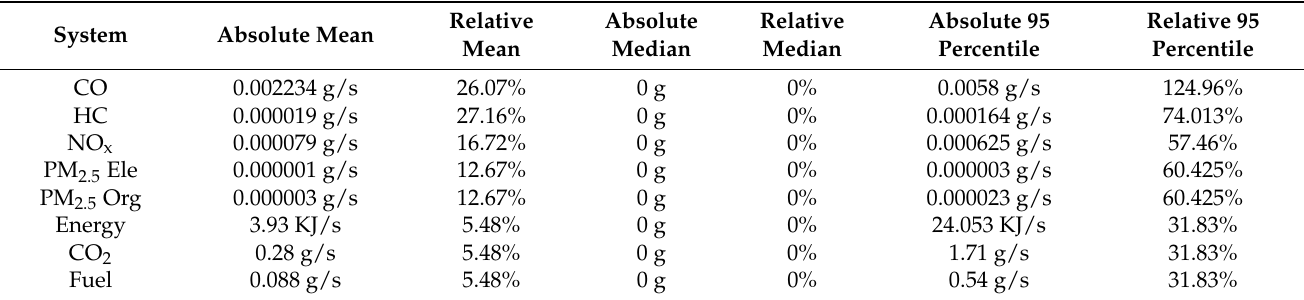
Table 2. Errors of emission estimations based on the speed estimations computed by our system compared with ground truth data.